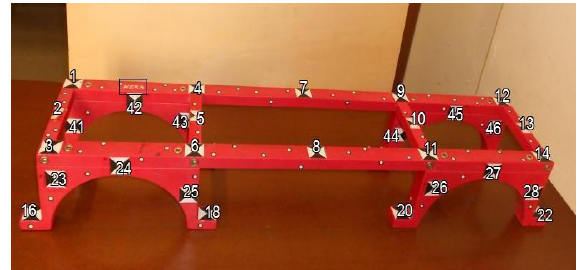
Figure 5. Calibration frame (II)